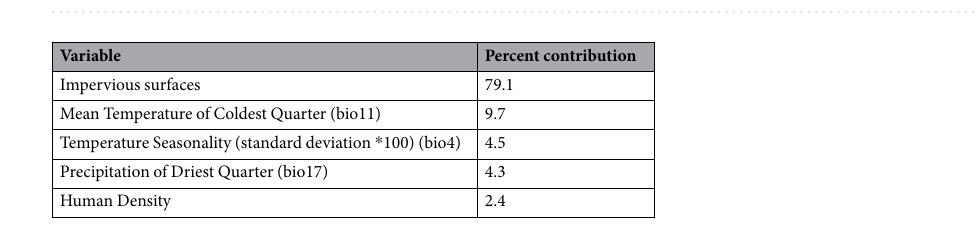
Figure 1. Occurrence records of common mynas in Israel used in this study during four different periods: the year of invasion, 1997; until 2002; until 2010 and until 2018. Presence records are marked with black circles.